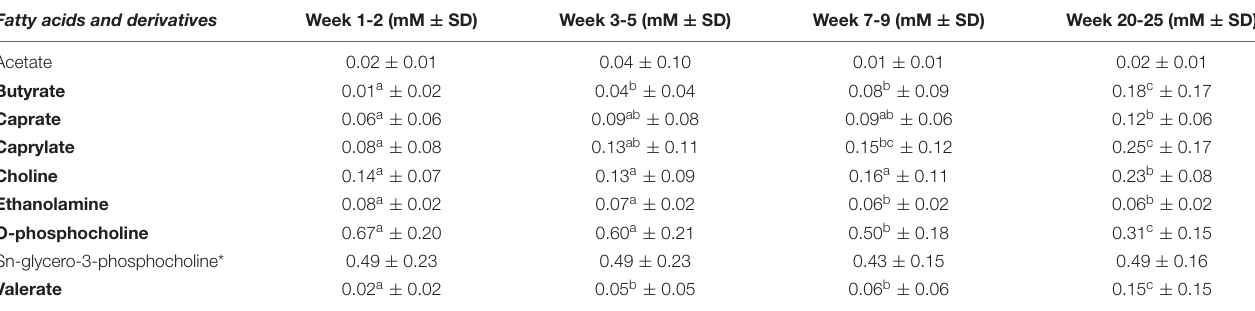
Fatty acids and